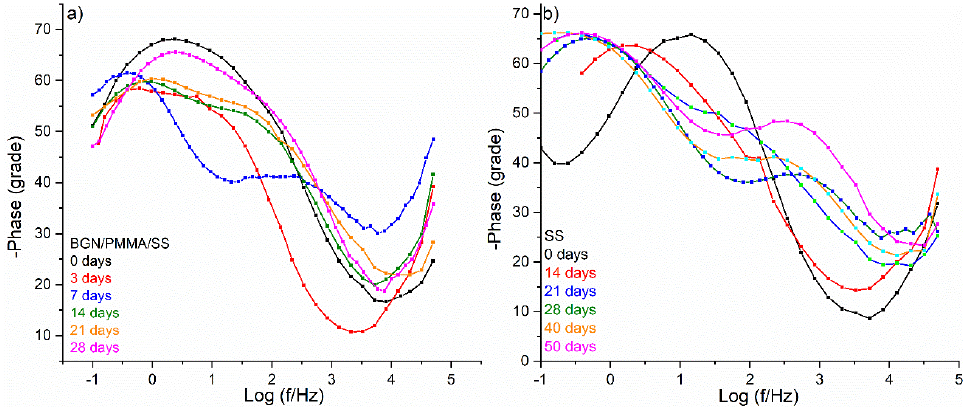
Figure 10. Bode diagrams for BGN/PMMA/SS ( a ) and SS ( b ) samples after different immersion time.